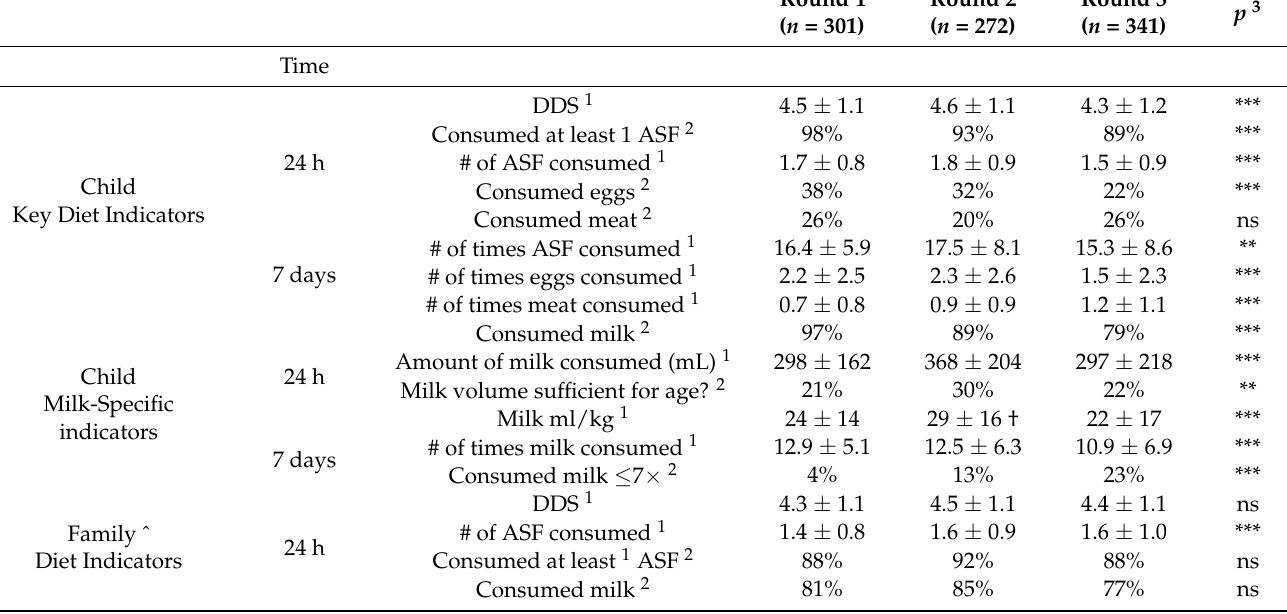
Table 2. Child and Family diet all 3 rounds. Diet indicators for children (key and milk-specific) and family are shown over the three survey rounds. Some indicators reflect diet intake over the previous 24 h and others over the previous 7 days. Significant differences (in bold) were found for nearly all child diet indicators over the three survey rounds; only 1 family diet indicator changed significantly over the three survey